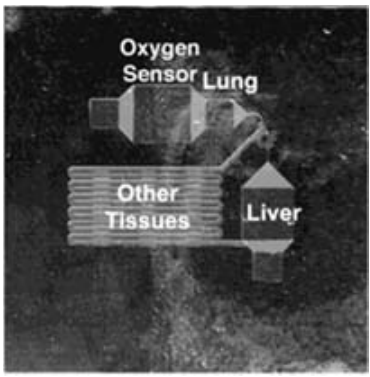
Figure 6. Photograph of the fabricated three-chamber microfluidic cell culture analog device with integrated optical oxygen sensor. Reprinted from [81] with permission from John Wiley and